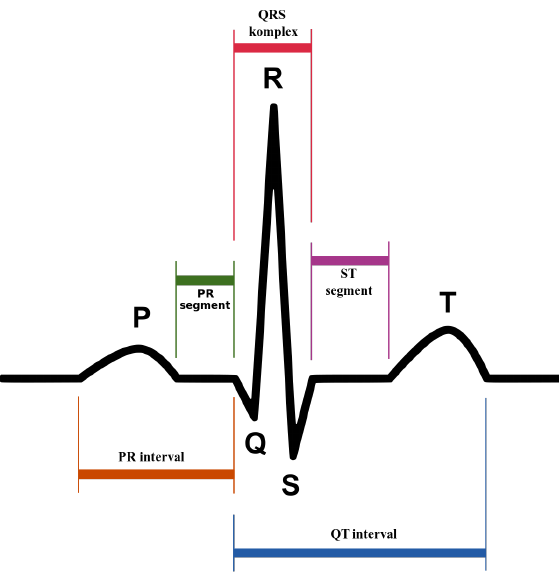
Figure 1. PQRST complex: the pattern of electrical activity of the heart during one cardiac cycle as recorded by electrocardiography. Created by Anthony Atkielski, source: https://www.wikilectures.